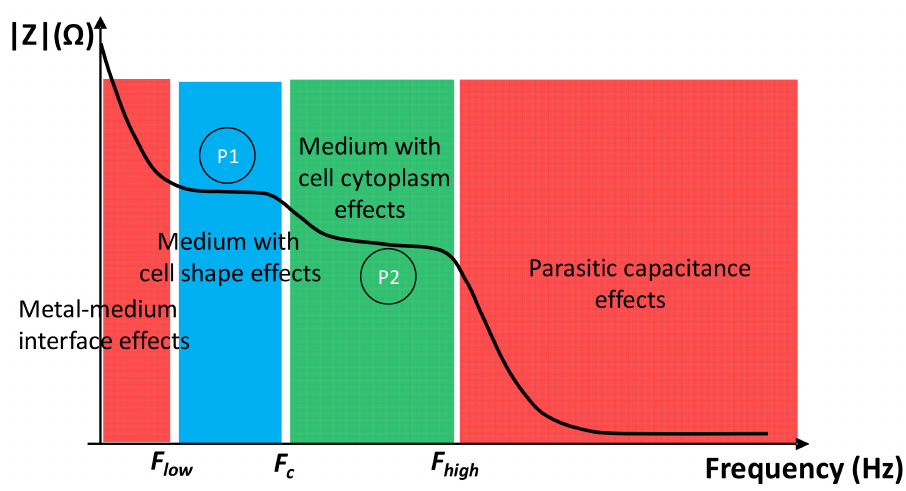
Figure 3. Schematic drawing of the impedance versus the frequency bands. The red zones represent the undesired intrinsic e ff ects, and the blue and green zones represent the e ff ects of the medium and of the biological